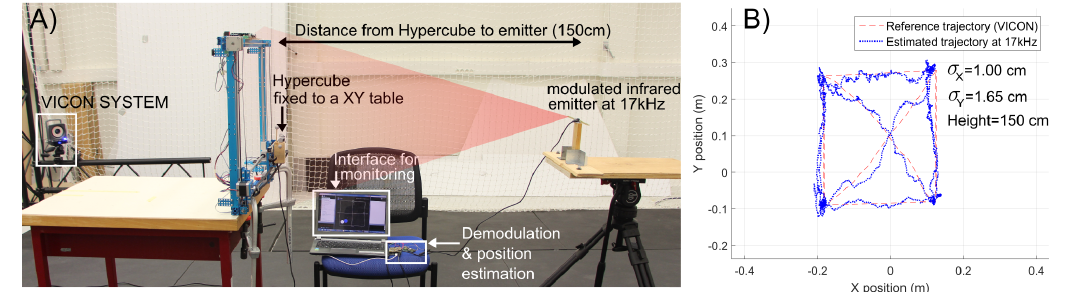
Figure 6. 2D localization of HyperCube moved by hand using a XY table with respect to a fixed IR LED flickering at 17 kHz placed ahead of the sensor at a distance of 150 cm. The position estimation is based on the parameters obtained in the calibration procedure: ( A ) experimental setup; and ( B ) experimental results. The standard deviation for X estimation is only 1 cm and the standard deviation for Y estimation is 1.65 cm.